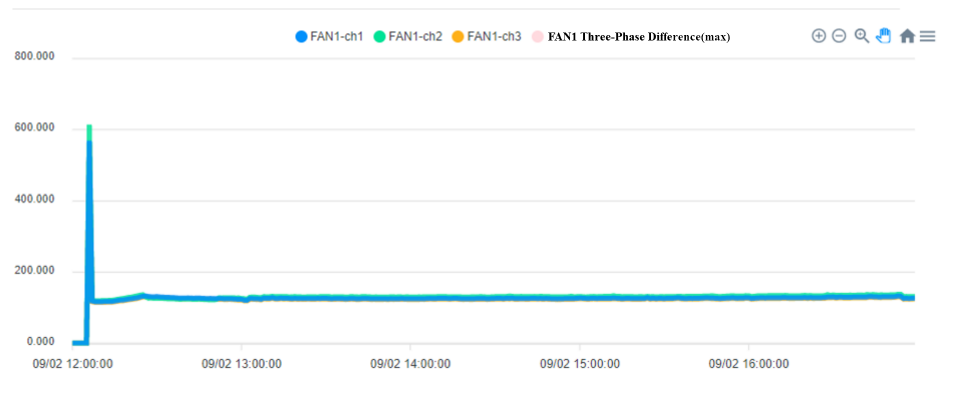
Figure 18. Fan Current system.